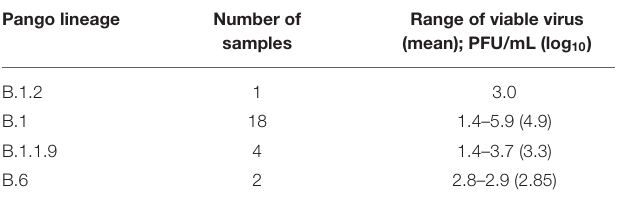
TABLE 1 | Summary of viable virus detection in nasal swab samples from unvaccinated individuals broken down by Pango lineage. Pango lineage